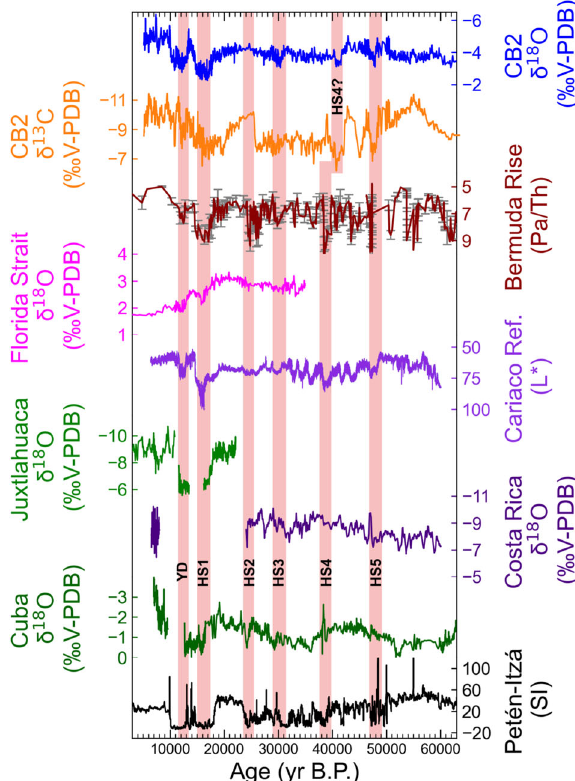
Fig.5|ComparisonofCB2withotherpaleoclimaterecords. ComparisonofCB2 δ 13 O(blue)and δ 13 C(orange)toPa/Thratios(burgundy;Henryetal. 111 )withFlorida Strait gulf stream circulation (magenta 49 ), Cariaco Basin re fl ectance (purple 74 ), Juxtlahuaca(lightgreen 22 ),CostaRica(blue 108 ),Cuba(darkgreen 46 )andLakePetén- Itzá (black 50